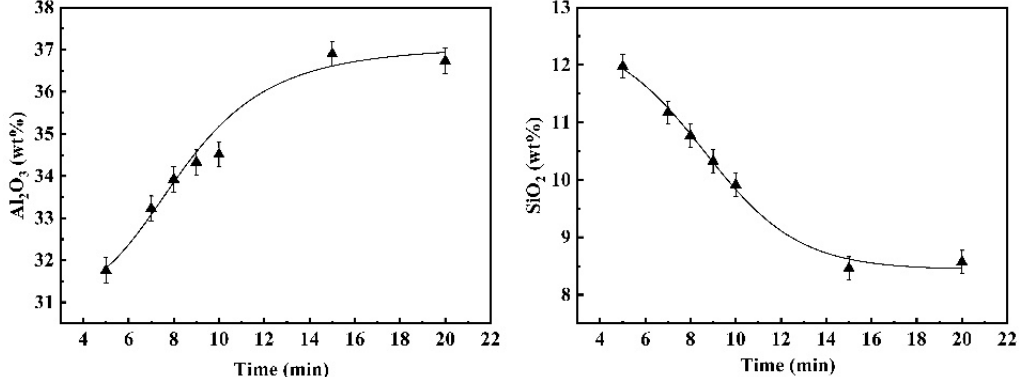
Figure 19. Composition change of mold flux during reaction between Fe-13Mn-5Al alloy and molten flux.